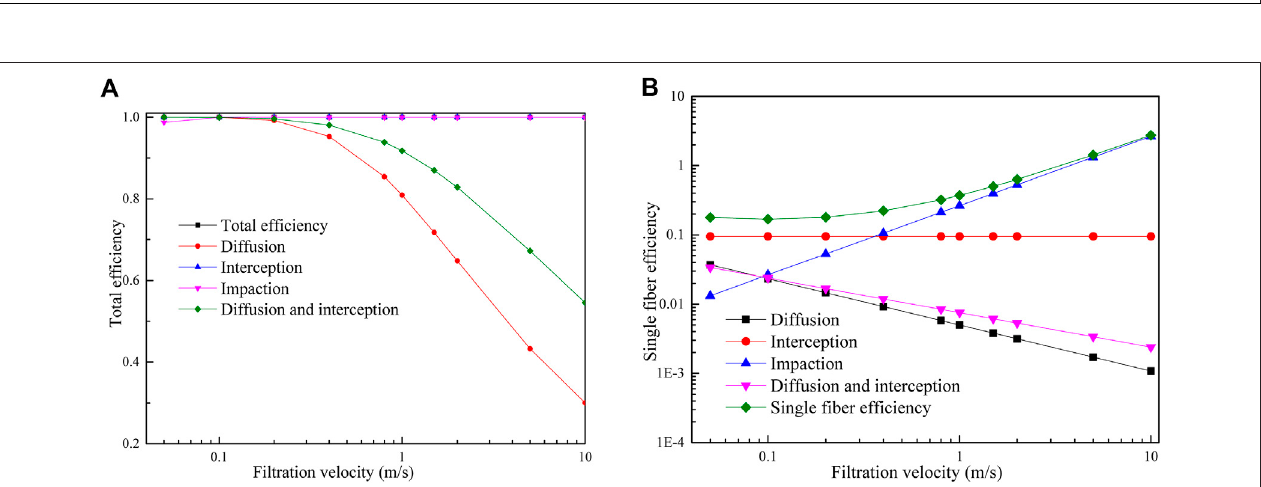
FIGURE 8 | Effect of fi ltration velocity on fi ltration ef fi ciency: (A) Total fi lter ef fi ciency; (B) Single- fi ber ef fi ciency.